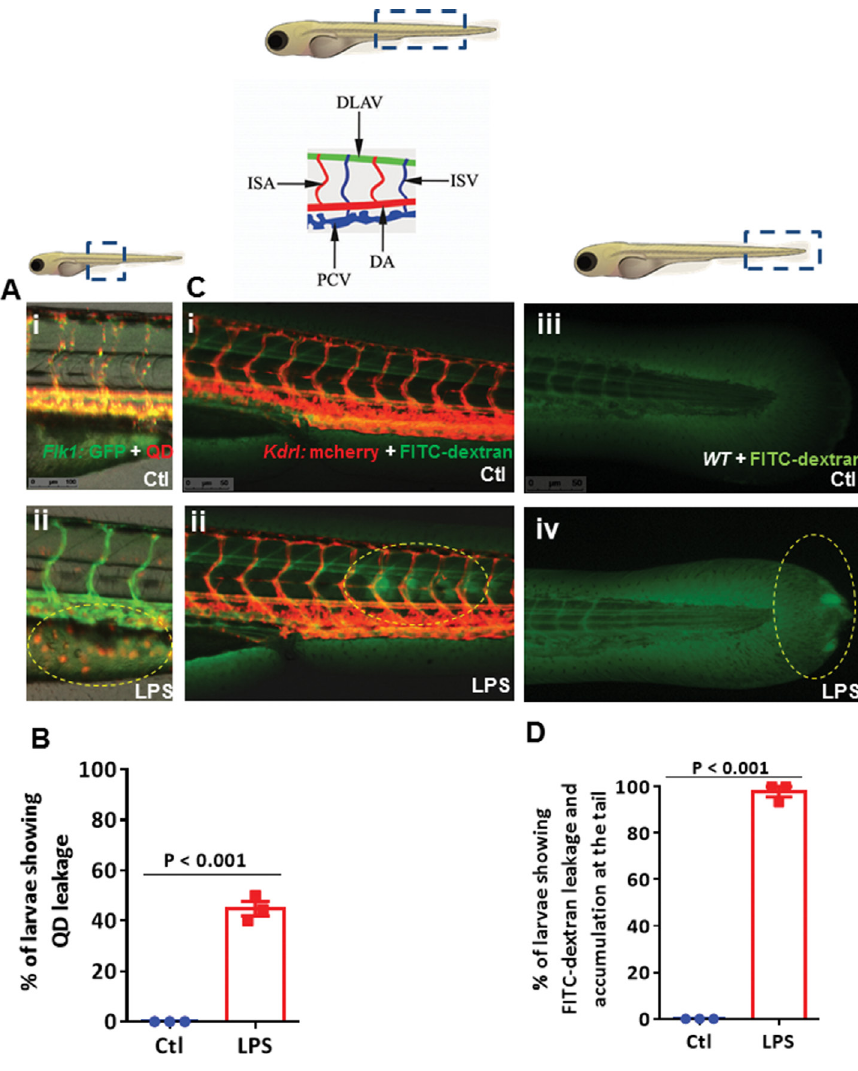
Figure 2. Use of transgenic zebrafish lines and microangiography contrast agents help visualize vascular leakage. The use of transgenic zebrafish lines ( Flk1: GFP and Kdrl: mcherry) together with injection of microangiography contrast agents like QD605 and FITC-dextran, respectively, help visualize LPS-induced vascular leakage in 3DPF zebrafish larvae. (A, B) While QD605 are useful in detecting major leaks at the region below the PCV (an average of 3 trials of 9–14 larvae per treatment), (C, D) FITC-dextran is better suited for visualizing minor leaks through the ISVs and the subsequent accumulation of the leaked out dextran at the tail fin (an average of 3 trials of 10–15 larvae per treat- ment). DLAV: dorsal longitudinal anastomotic vessel; ISA: intersegmental artery; ISV: intersegmental vein; PCV: posterior cardinal vein; DA: dorsal